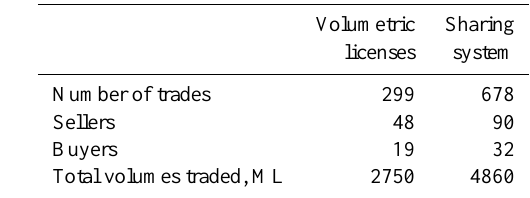
Table 2. Numbers of trades, buyers and sellers, and volumetric an- nual totals under the two licensing regimes for a simulated histori- cal dry year (ML, millions of